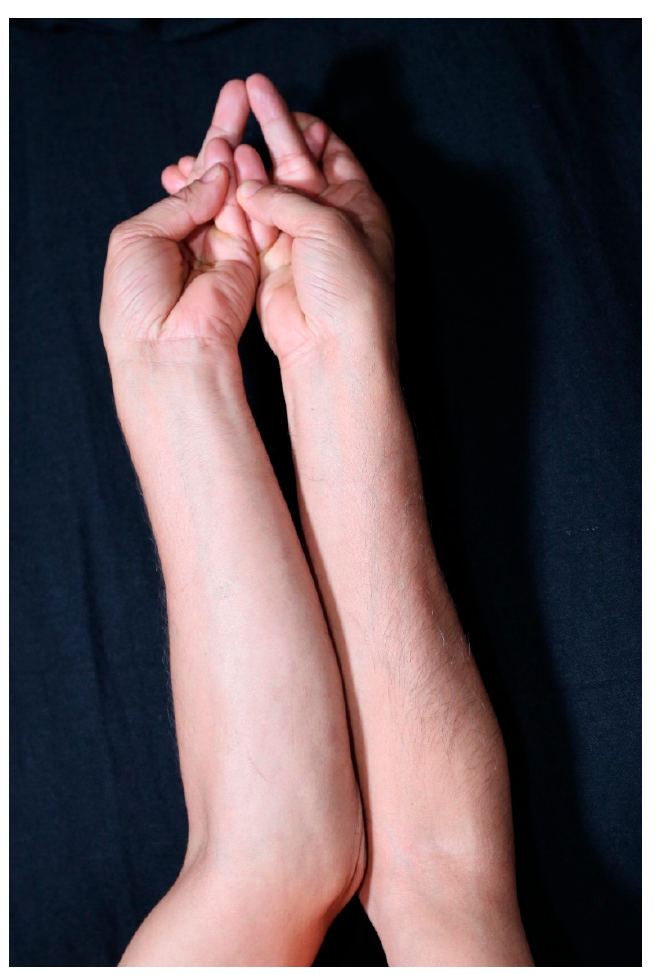
Figure 8. Khecar ī -Mudr ā . Figure 8.